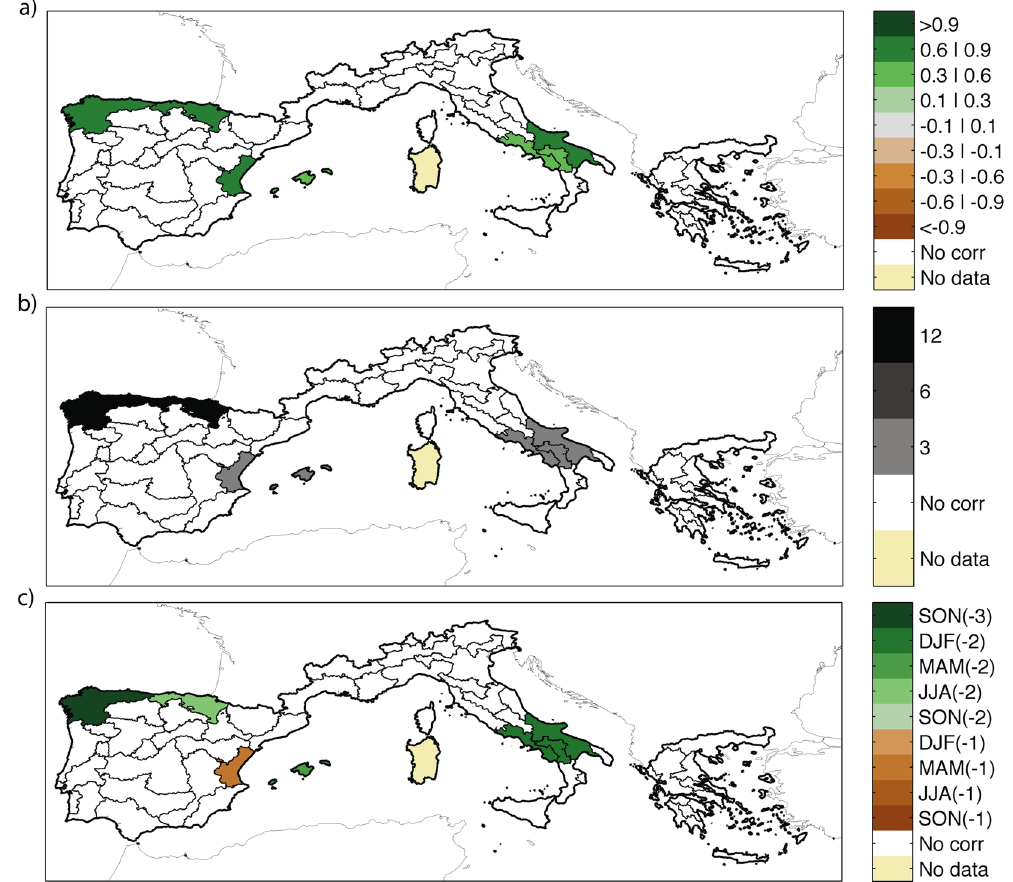
Figure 3. ( a ) Maximum significant partial correlations between detrended log( BA ) and SPEI; ( b ) accumulation time scale (3, 6 and 12 months) of the SPEI; ( c ) seasons when the antecedent SPEI is calculated. Only correlations that are collectively significant from an FDR test 45 are shown. This figure is created with Matlab version R2012a